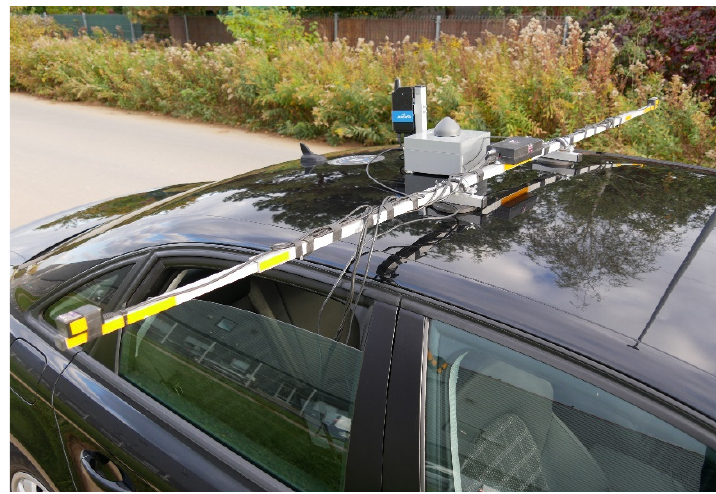
Figure 5. Light intensity measuring system with GPS RTK mounted on the roof of the vehicle.